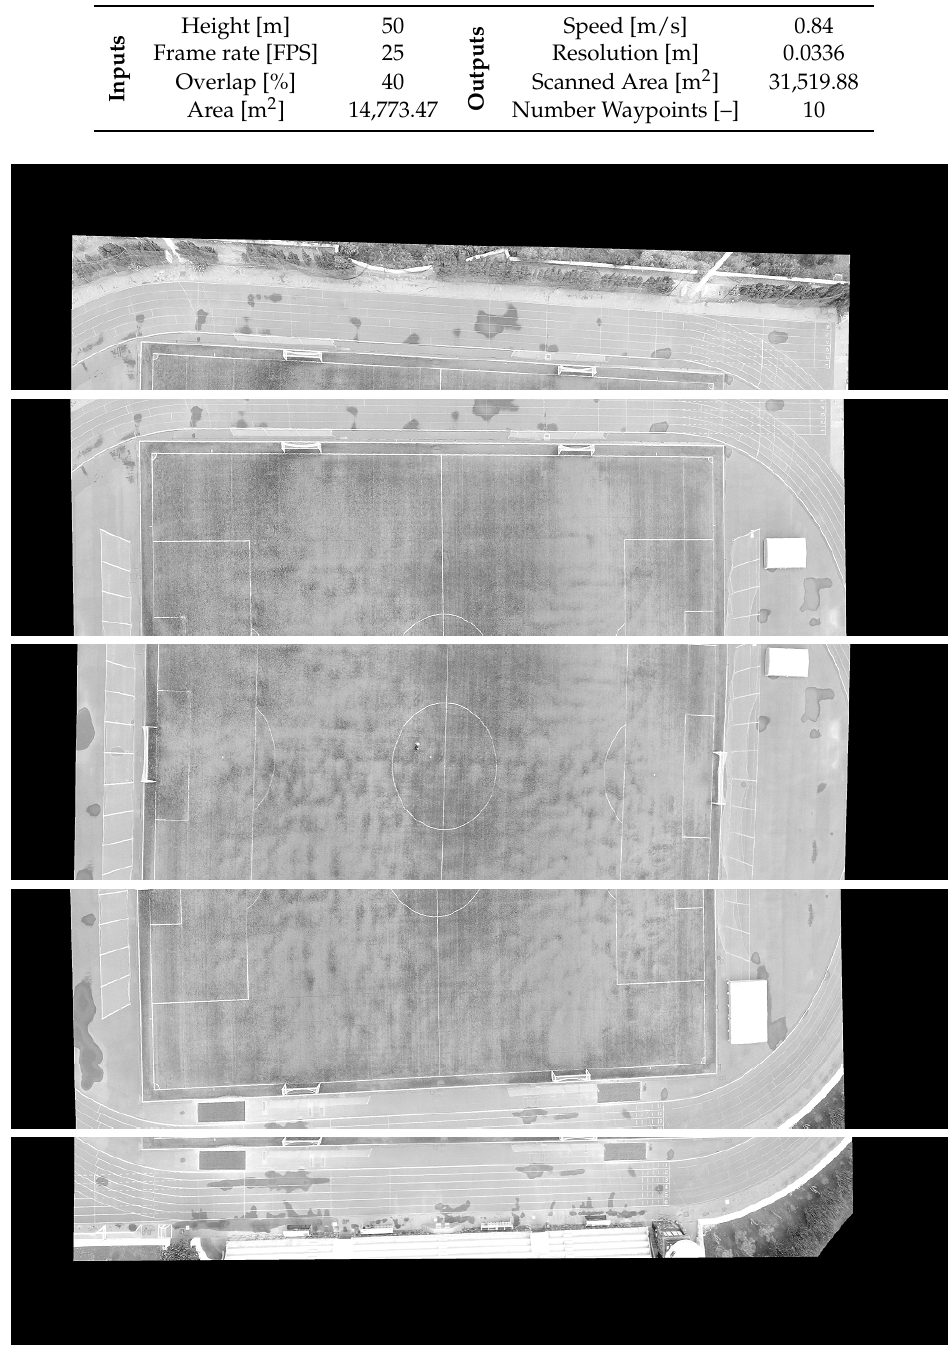
Figure 13. Captured